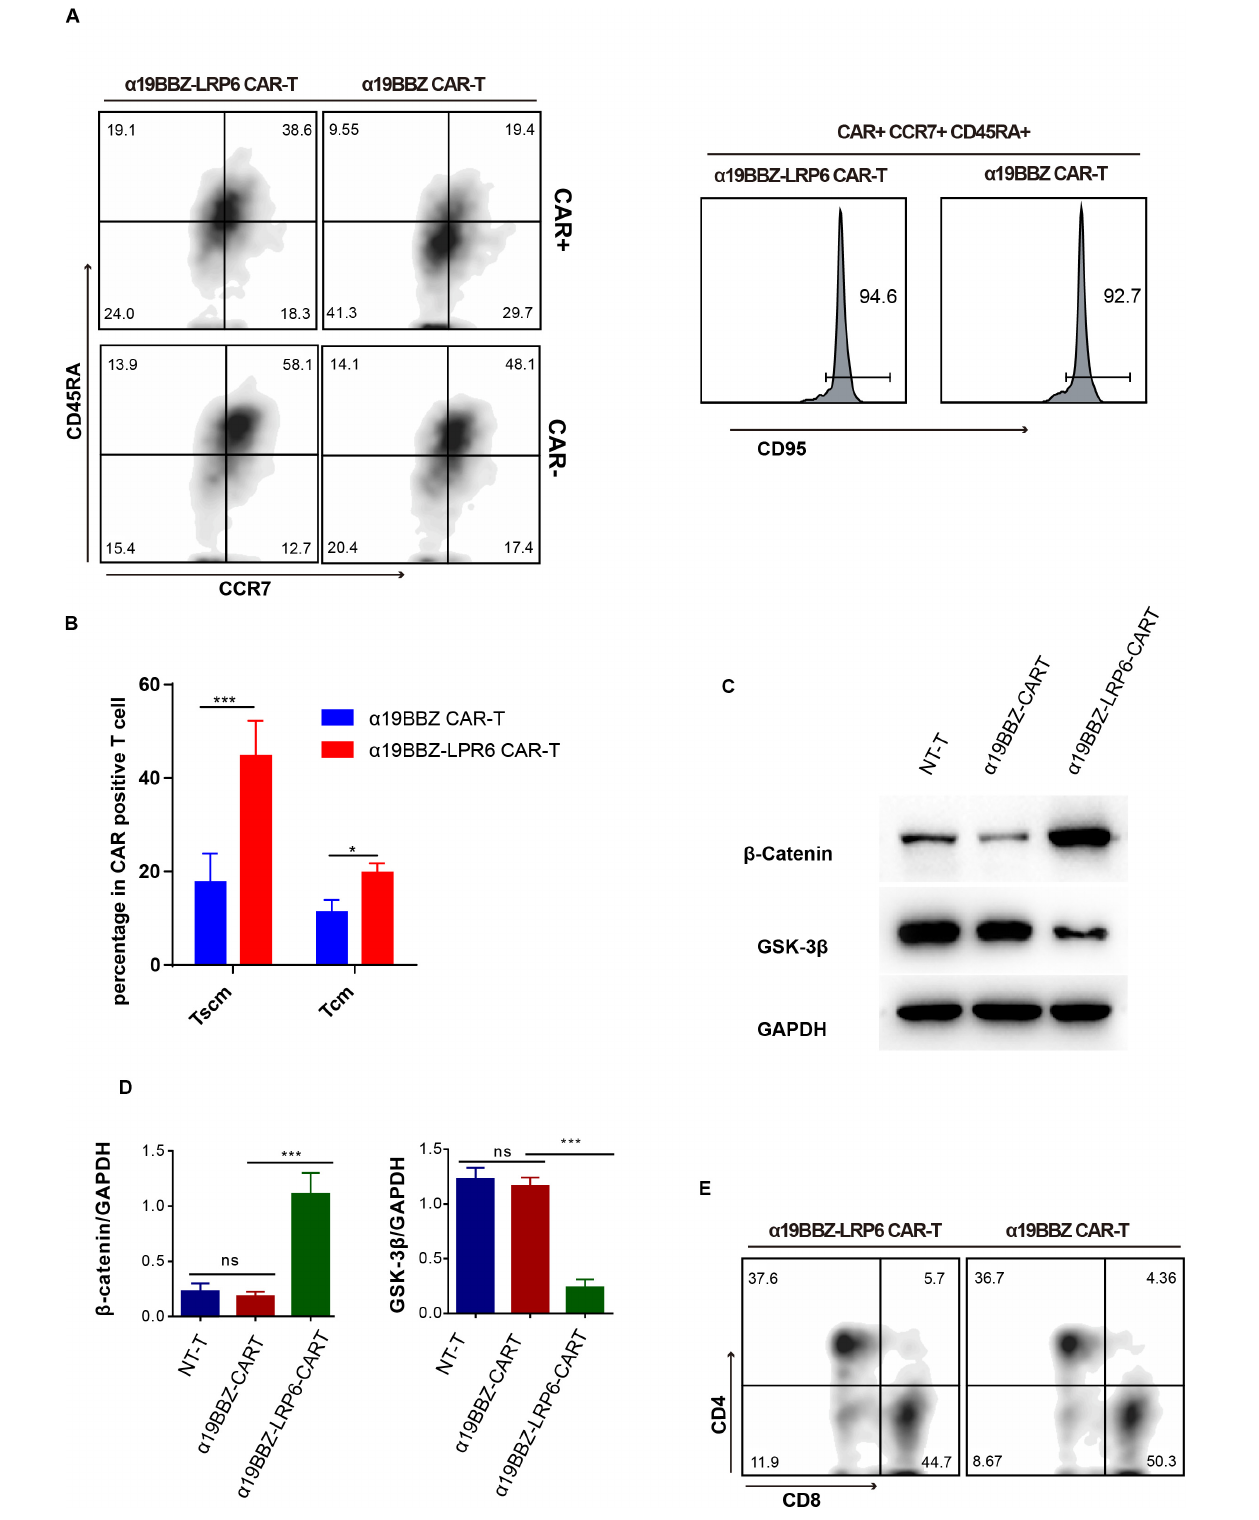
FIGURE 2 | The Phenotype of CAR-T cells. (A) Representative flow cytometric analysis for memory biomarker detection and (B) statistics of Tscm from five donors. (C) Flow cytometry for CD4 and CD8 proportion. (D) Western blotting and statistical analyses for the wnt signaling pathway in CAR-T cells and NT-T cells. Error bars indicate mean ± SD ( n = 3), * P < 0.05; ** P < 0.01; *** P < 0.001.